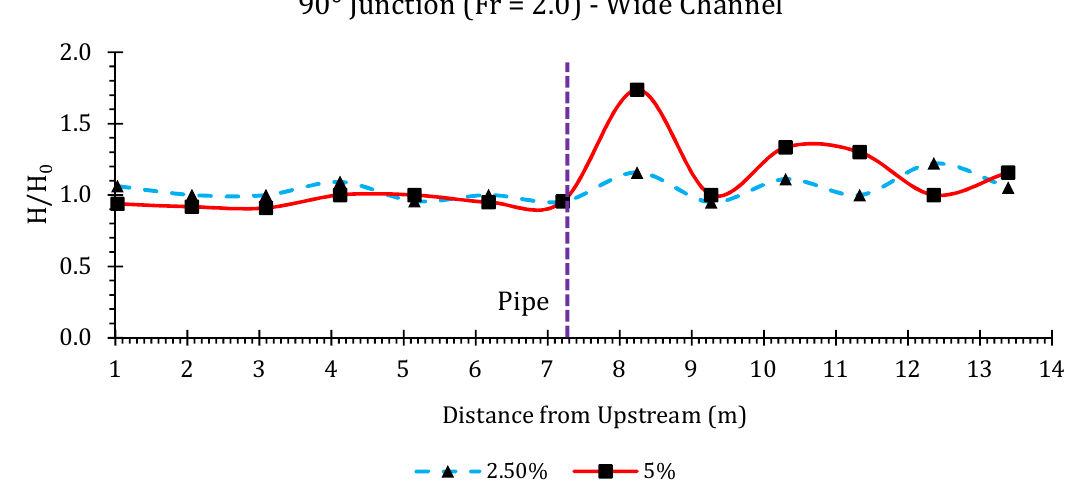
Figure A15. Water height ratios in a 90° junction for Fr = 2.0 in the wide channel.